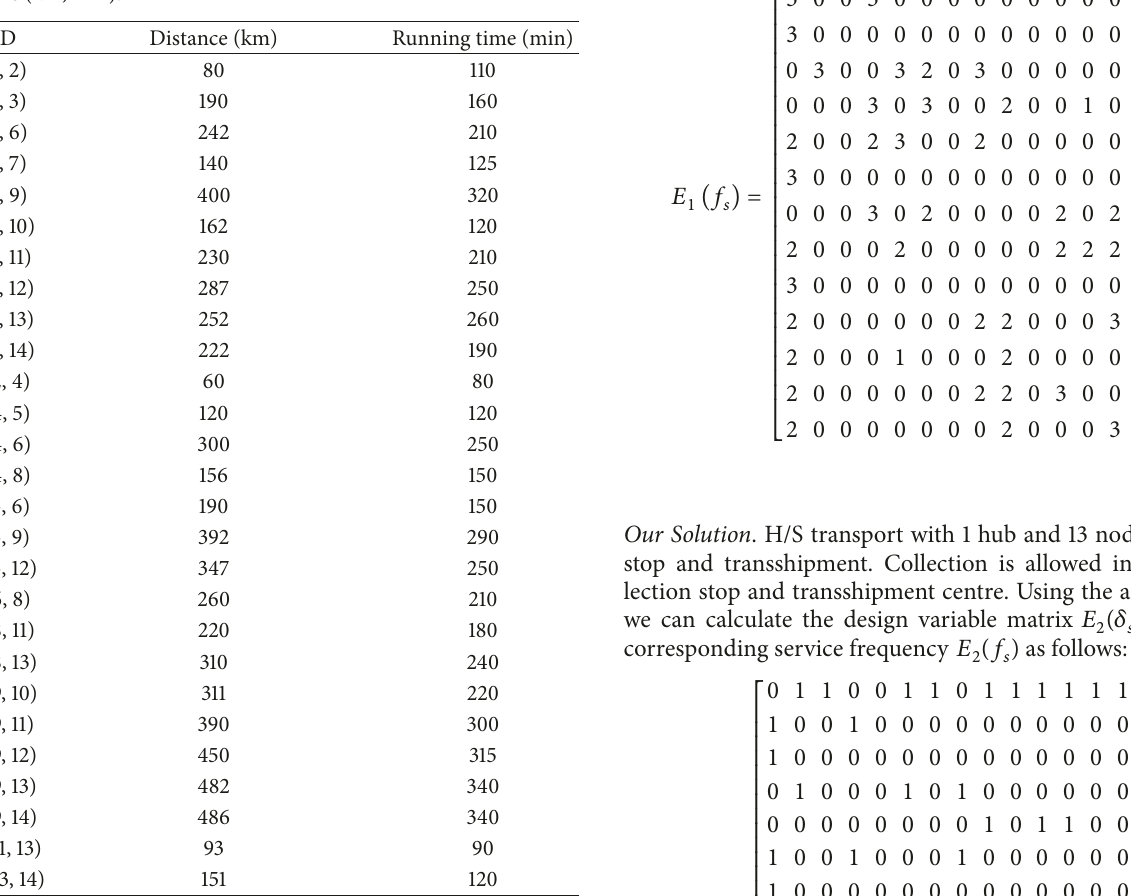
Table 1: Passenger transport distance and running time between ODs (km,